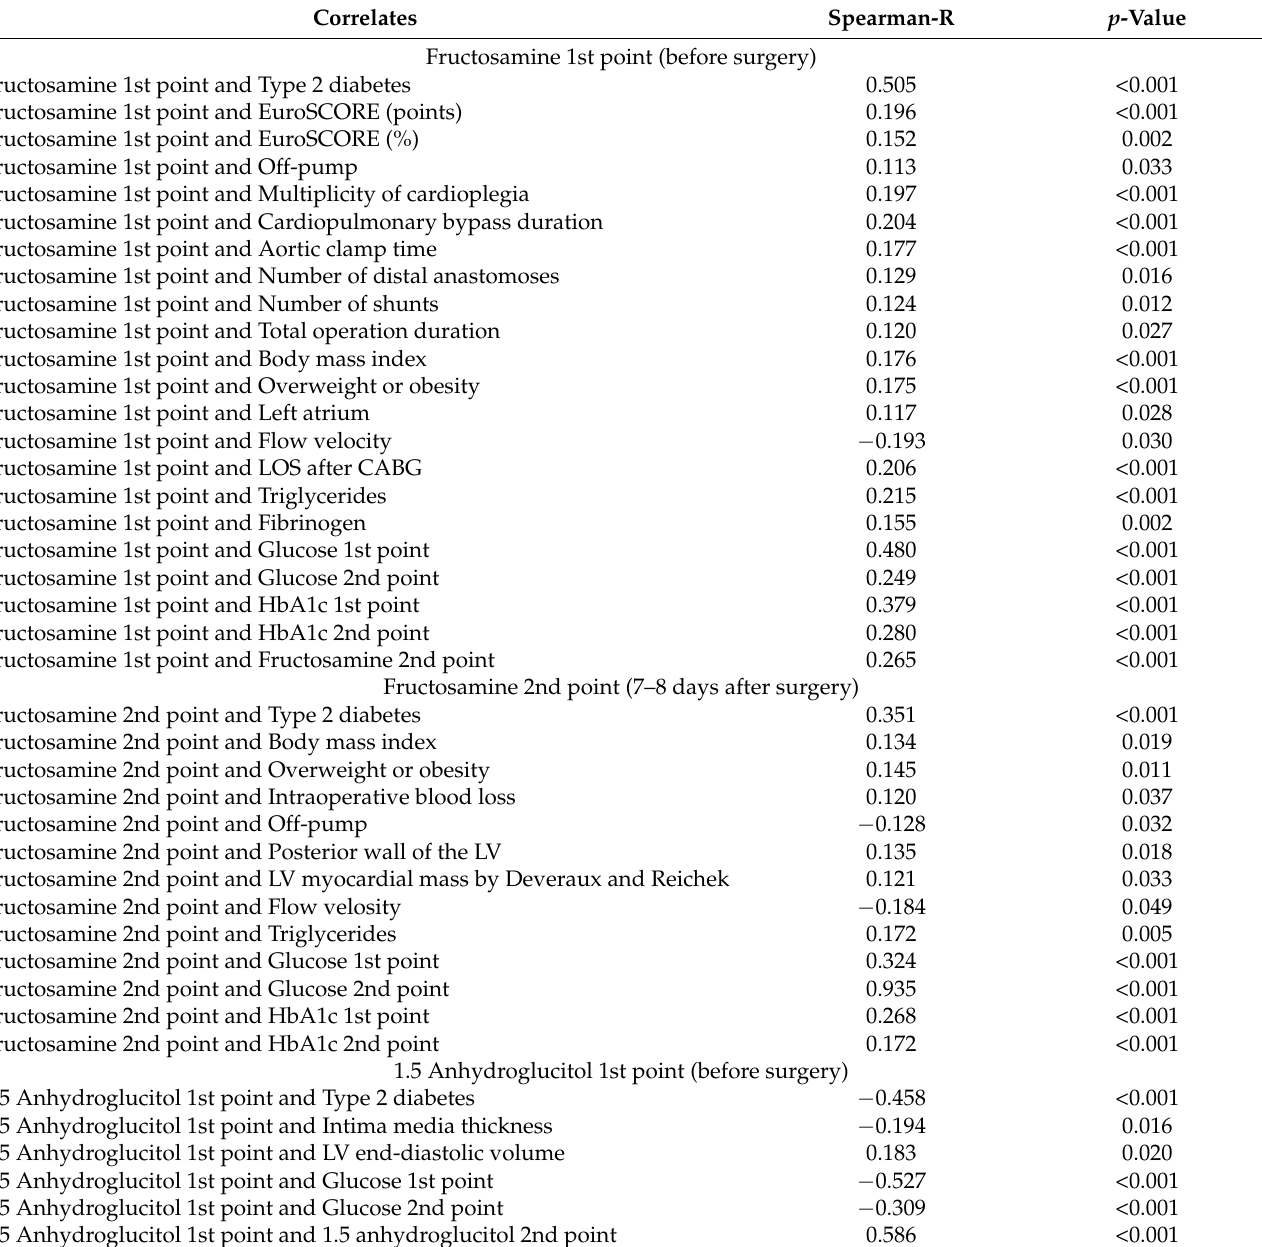
Table 4. Correlation of fructosamine and 1.5-anhydroglucitol with clinical characteristics of patients. Correlates Spearman-R p -Value Fructosamine 1st point (before surgery)